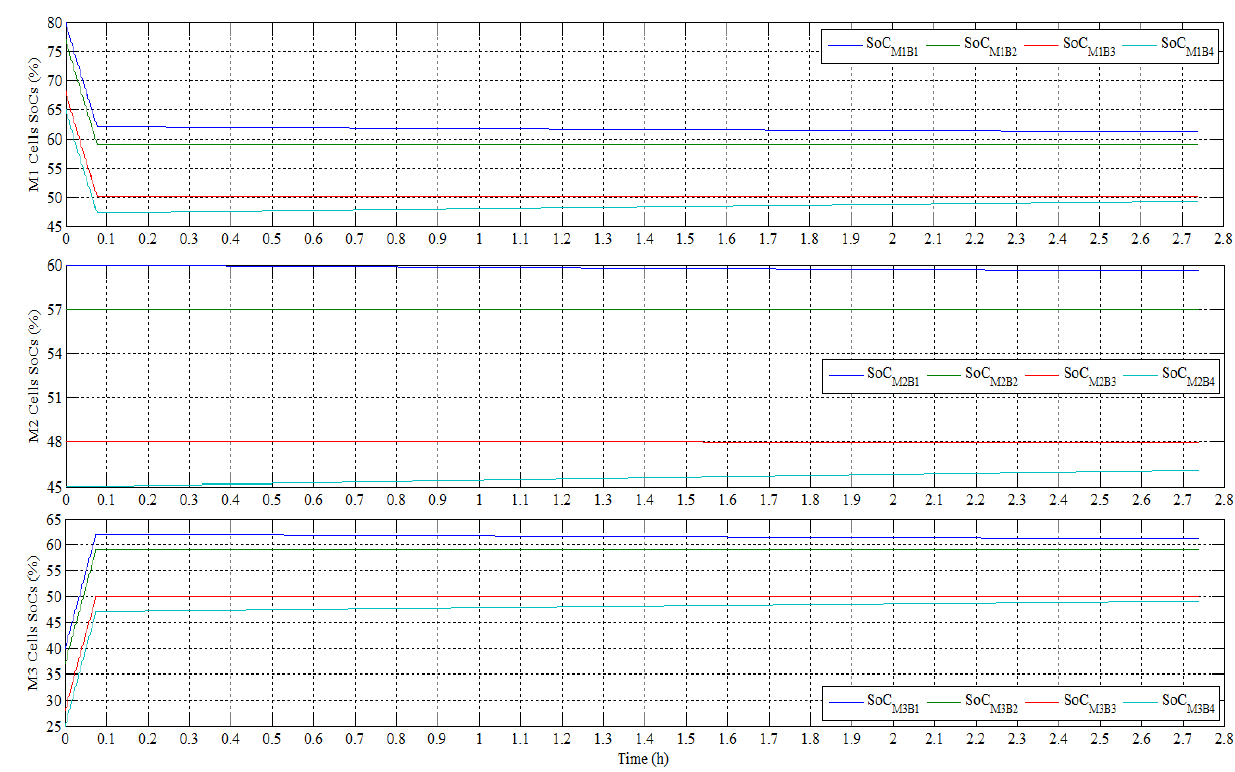
Figure 12. Simulation No. 2 (proposed SSCs and BC) results: Module 1 cells SoCs, Module 2 cells SoCs and Module 3 cells